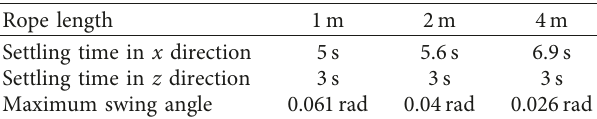
Table 3: Performances of the proposed control scheme for different operating